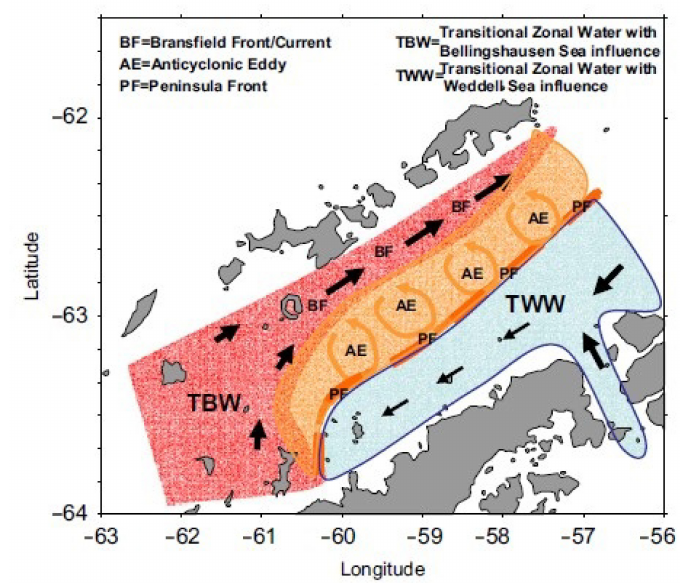
Figure 5. Diagram of the main components of the Bransfield Strait surface current system